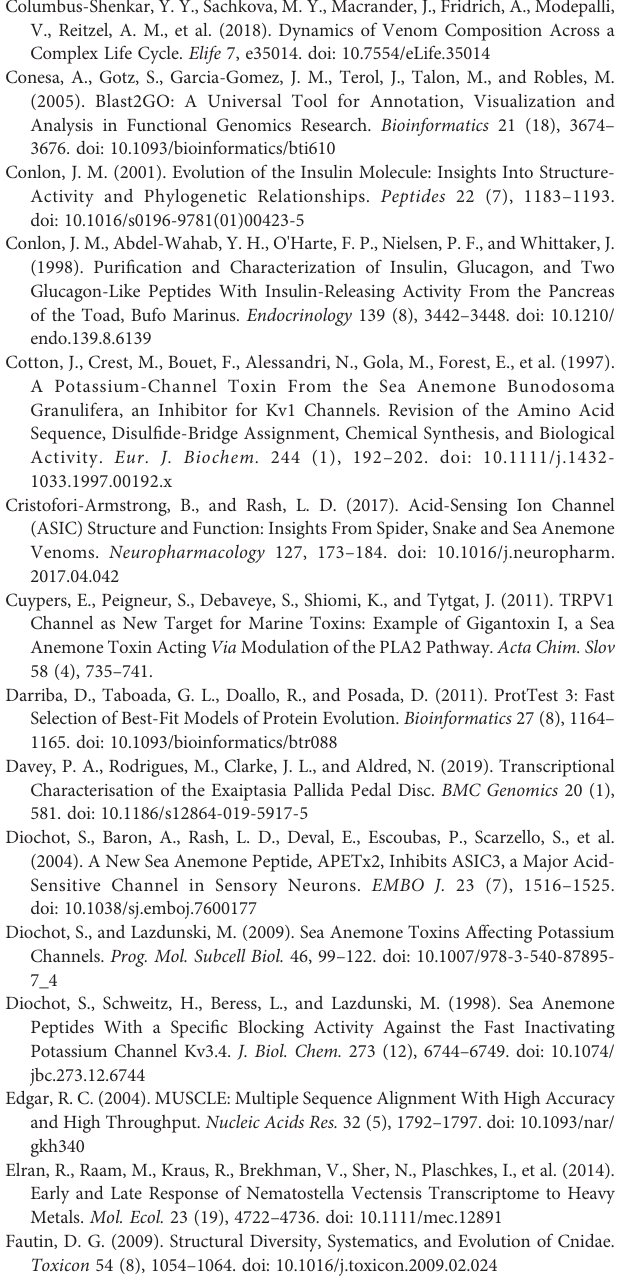
Supplementary Figure 1 | Comparison of the number of Exaiptasia diaphana gene annotations between different databases. Supplementary Figure 2 | KEGGpathwayoftheseaanemone Exaiptasiadiaphana . Supplementary Figure 3 | GO analysis of the sea anemone Exaiptasia diaphana . Supplementary Figure 4 | KEG analysis of Exaiptasia diaphana